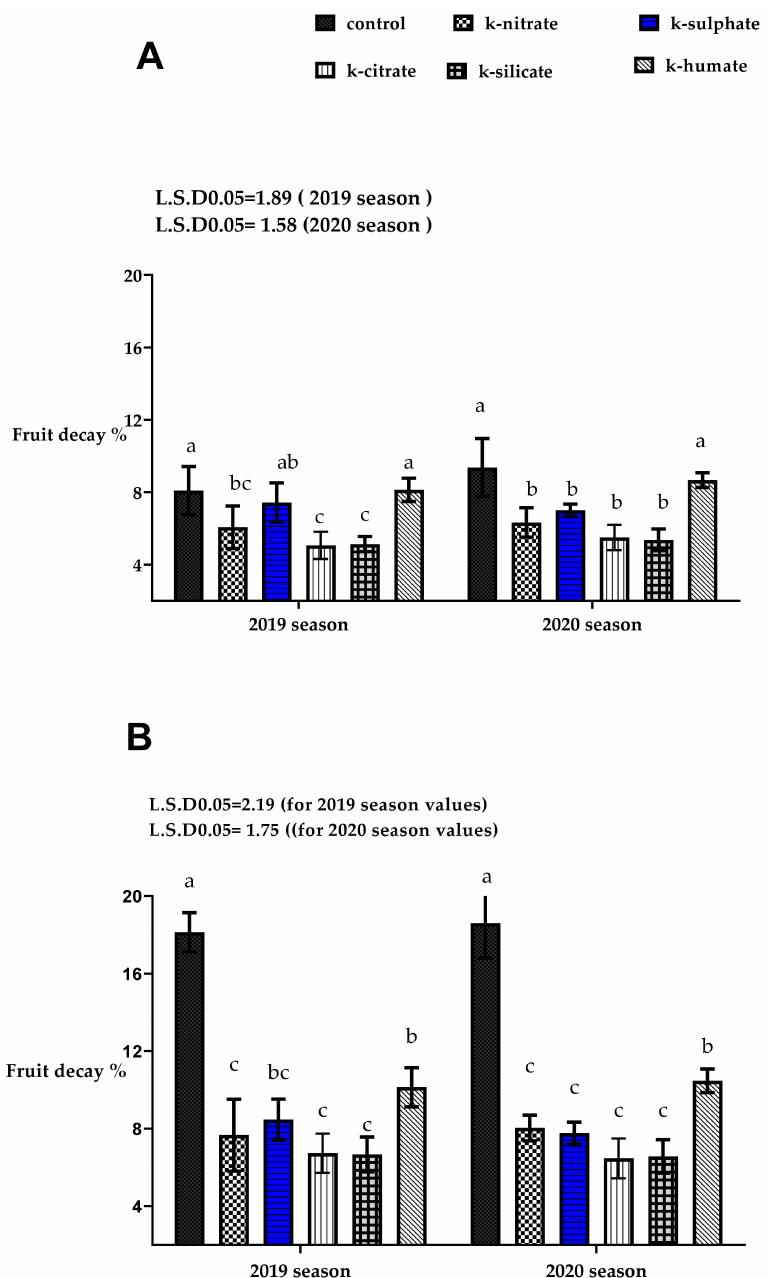
Figure 6. Effect of diverse potassium forms as foliar application on fruit decay % of apricot trees cv. ‘Canino’ ( A ) after storage at 7 plus 2 day on ambient temperature and ( B ) after storage at 21 day plus 2 days at ambient temperature in 2019 and 2020 seasons during cold storage 0 ± 1 ◦ C and 90 ± 5% RH. Values represent the mean with SD. Letters above each bar shown indicating significant differences among the tested treatment, if letters were same corresponding treatments are statistically equal and vice versa according to Duncan’s multiple range tests at p <